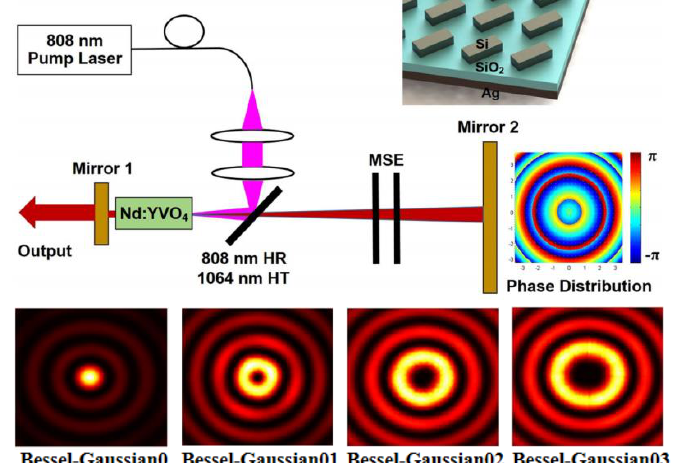
Figure 18. Experimental setup of the structured light laser. Simulated multi-ring intensity distribution of OAM-carrying Bessel beams with different modes (Adapted from an open-access source Ref. [114]).